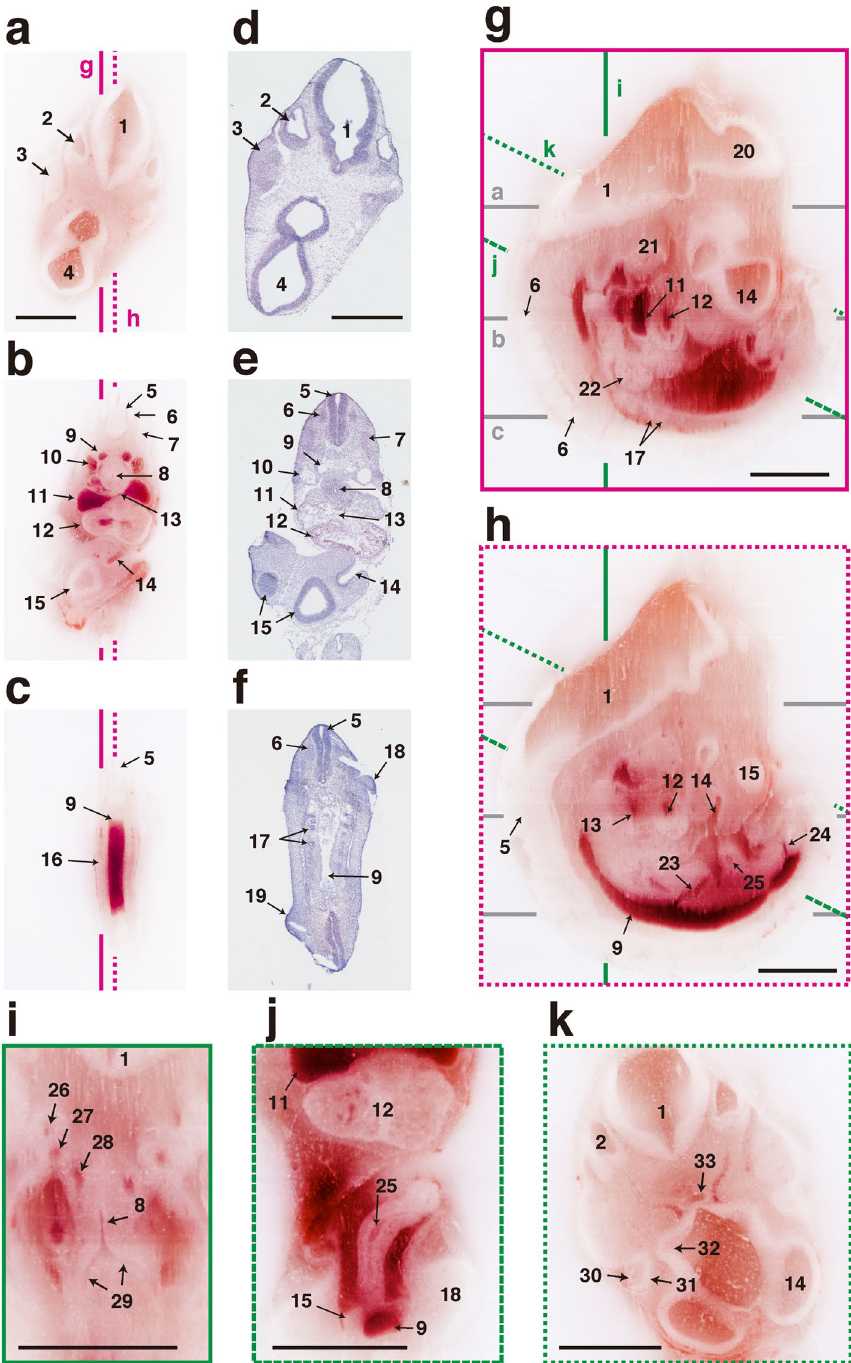
Figure 2. Correlation between 2D images and MPR images of E10.5 mouse embryo. A mouse embryo was imaged by the CoMBI system and shown as MPR images. ( a – c ) Block-face images. ( a – c ) Frozen sections were collected at the positions of ( a – c ). ( g , h ) The sagittal planes were made by MPR from 565 block-face images. The nervous, cardiovascular, and urogenital systems are shown. ( i ) Reconstructed coronal planes of the thorax show the respiratory system and vascular system. ( j ) Reconstructed plane of the abdomen shows gastrointestinal tract. ( k ) Reconstructed plane of the head shows sensory organs. 1: myelencephalon, 2: otic vesicle, 3: